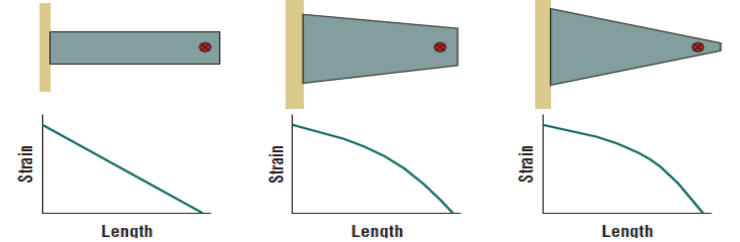
Figure 18. Trapezoidal beams ( © 2005 IEEE. Reprinted with permission from